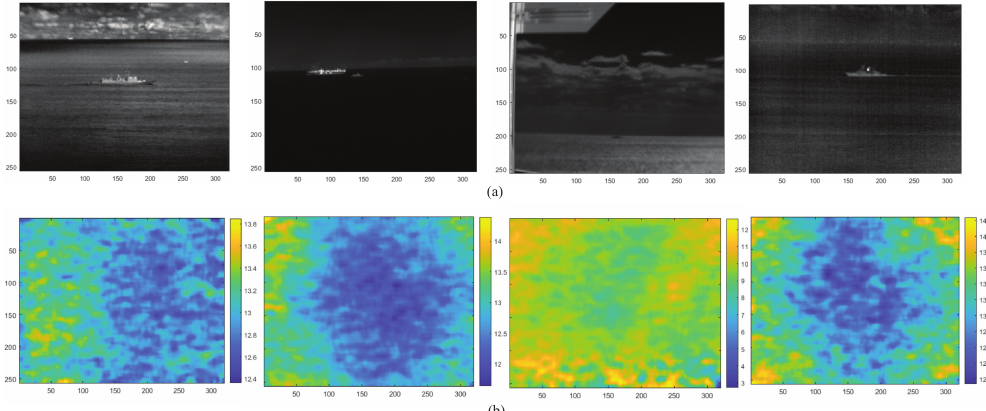
Figure 27. Various remote air temperature image visualization example in maritime environment: ( a ) broadband images; ( b ) corresponding VisualAT